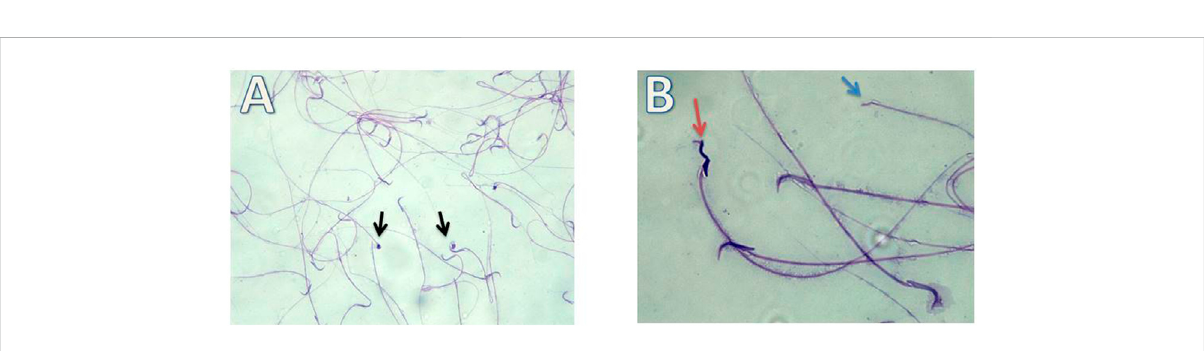
FIGURE 8 MicrographillustratingthemorphologyofspermsofCd-treatedalbinoratshowingmanyspermsabnormalitiesintheformof;absenceofhead (blue arrow), rounded head (black arrows) and tortuous head (red arrow). (H&E; (A) -X200, (B) -X400).